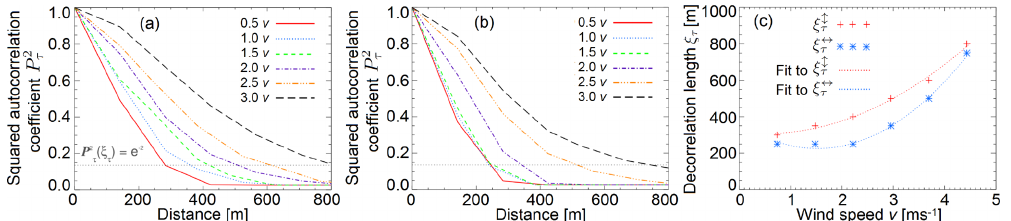
Figure 9. The six cases of different wind speed calculated 1-D autocorrelation functions (a) along and (b) across the main structures are identified in Fig. 8g–l. The grey dotted line marks the threshold of P 2 τ (ξ τ ) = e − 2 . (c) From (a) and (b) derived discrete values for the (cid:108) ↔ decorrelation lengths ξ τ and ξ τ as a funktion of wind speed v (symbols). Additionally included are fits derived from Eqs. (5) and (6) (dotted